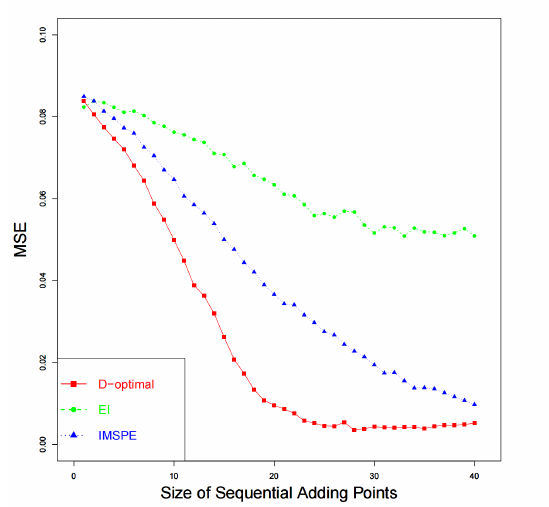
Figure 5. MSE l of θ obtained using the proposed sequential D-optimal method, EI method, and IM- SPE method by sequentially adding computer experiment